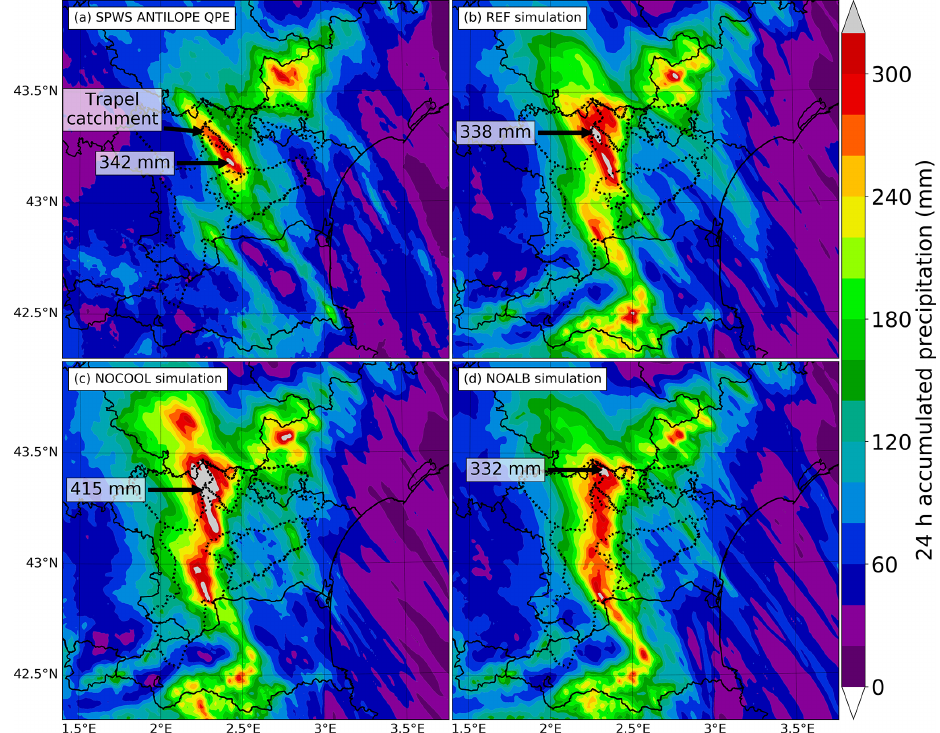
Figure 6. Accumulated precipitation over 24h between 12:00UTC on 14 October and 12:00UTC on 15 October from the (a) SPWS ANTILOPE QPE, (b) REF, (c) NOCOOL and (d) NOALB simulations. Solid black lines indicate French departments and country borders. Dotted black lines indicate catchment limits of the Aude basin and its